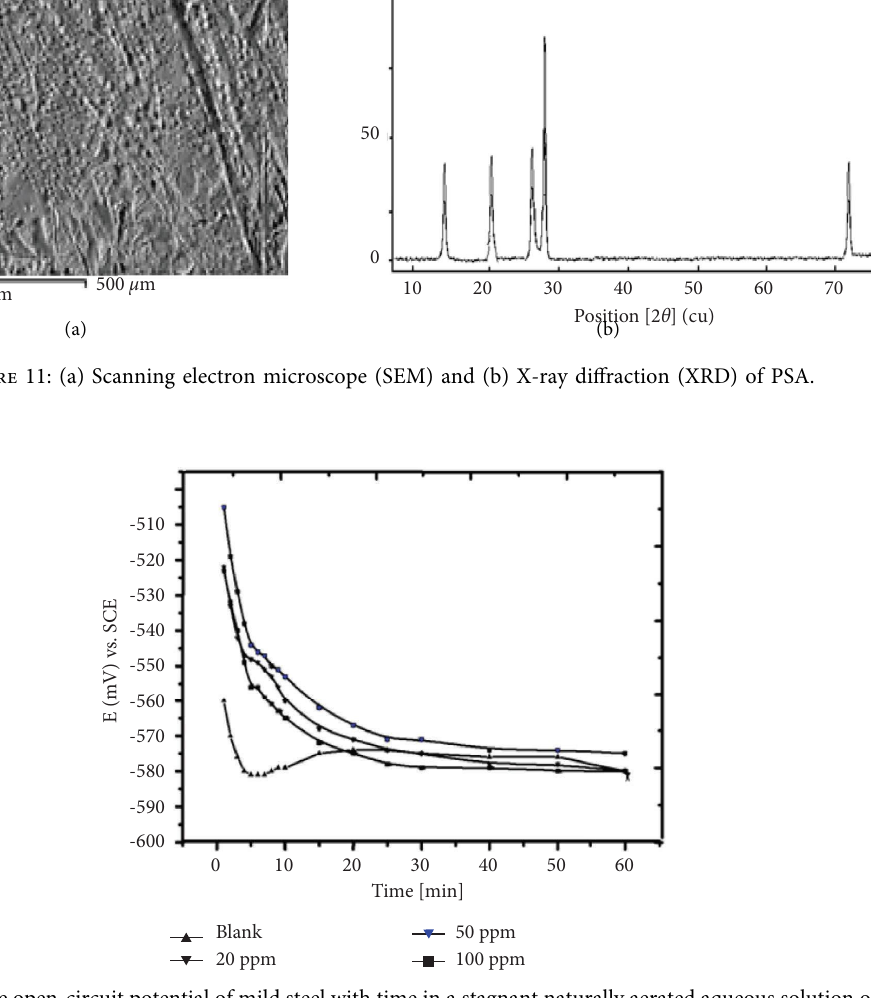
2 SO 4 at Figure 17. Te red and blue regions on the ESP indicated that the donor/acceptor atomic sites of SA and its dimer. HOMO